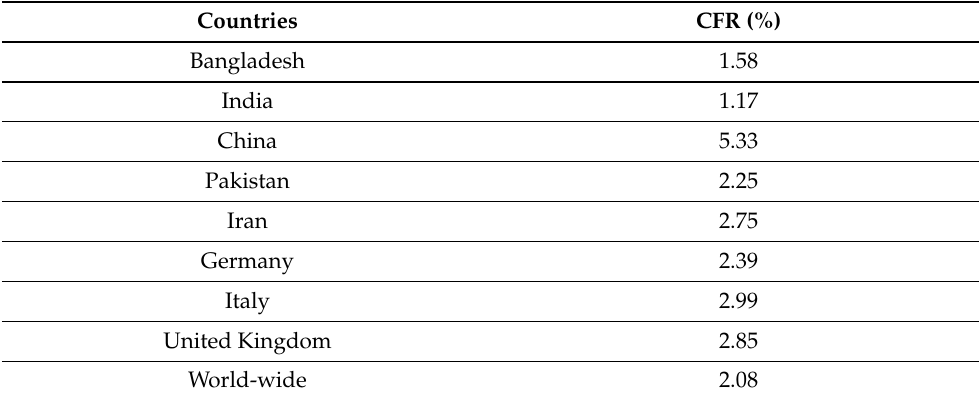
Table 4. Case Fatality Ratios of COVID-19 [53].